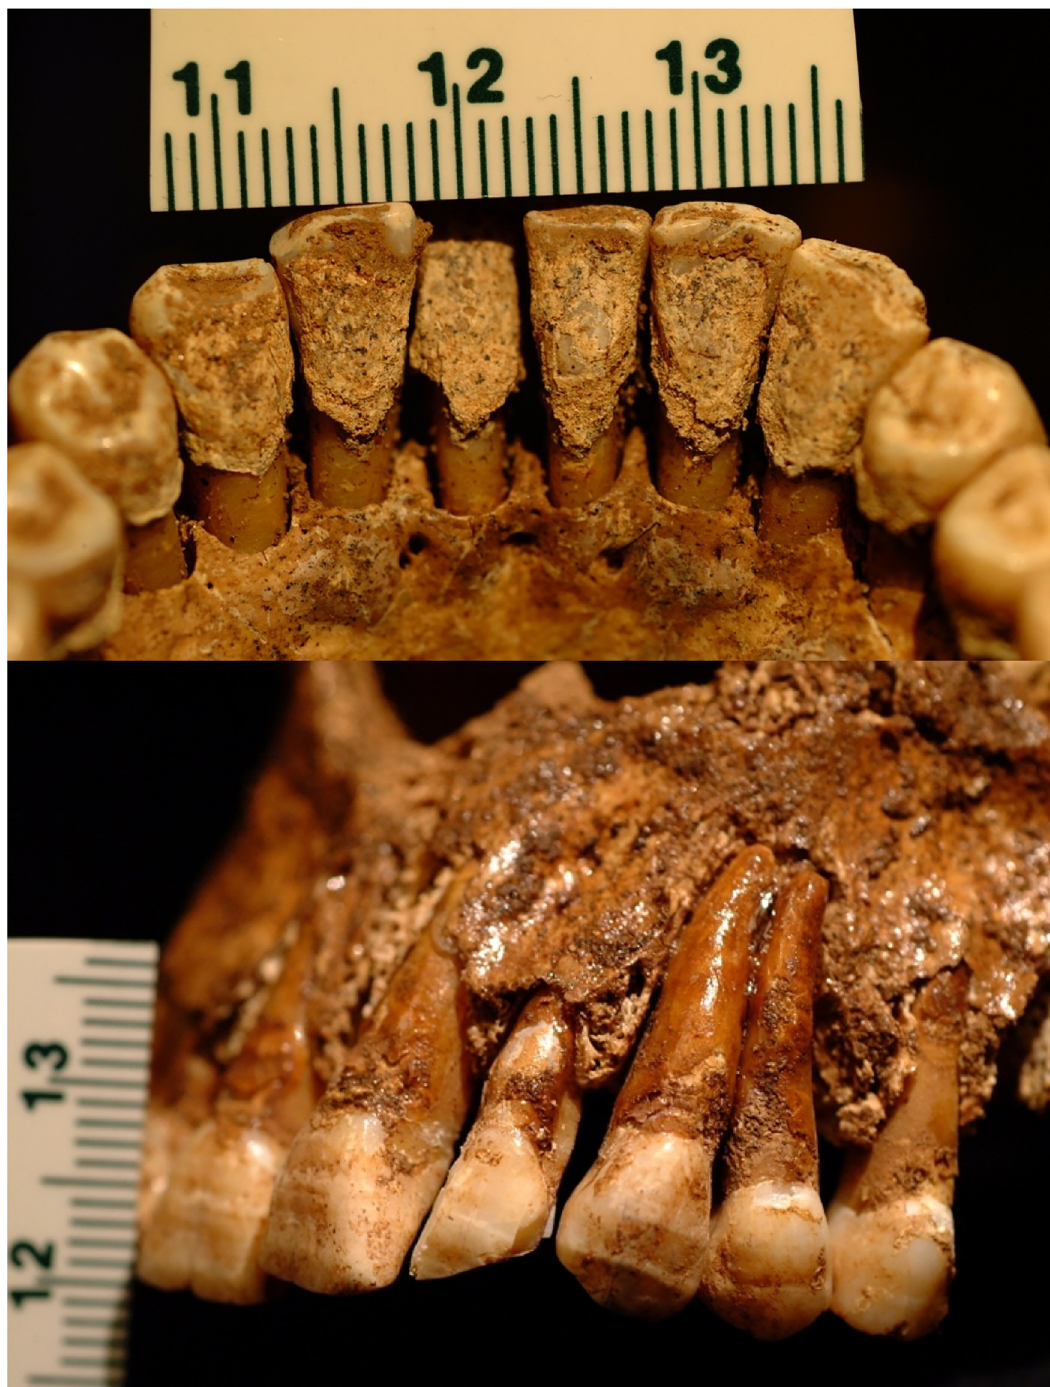
Fig 12. YNH4 dental pathologies. Top: dental calculus accretion on YN4 A anterior mandibular dentition. Bottom: serial linear enamel hypoplasias across YNH4 A maxillary incisors and premolars. See text for details.